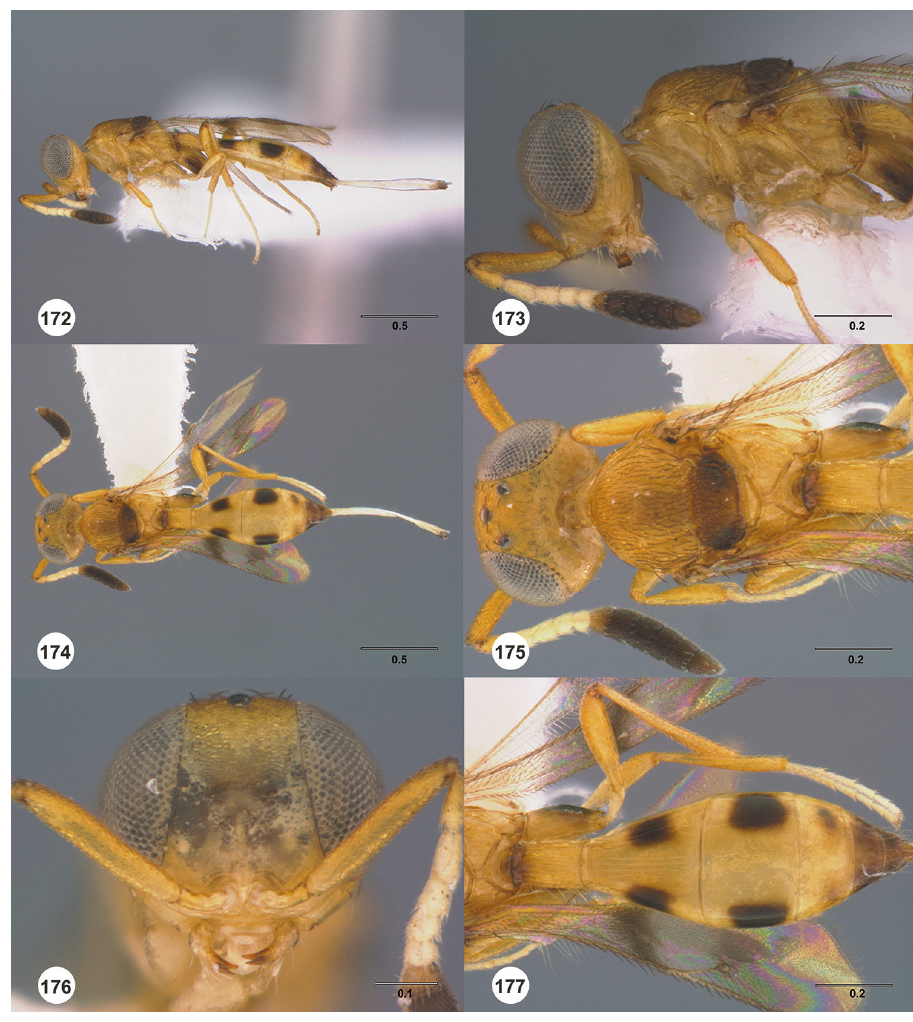
Figures 172–177. Calliscelio minutia sp. n., female, holotype (OSUC 433847). 172 Lateral habi- tus 173 Head and mesosoma, lateral view 174 Dorsal habitus 175 Head and mesosoma, dorsal view 176 Head, anterior view 177 Metasoma, dorsal view. Scale bars in